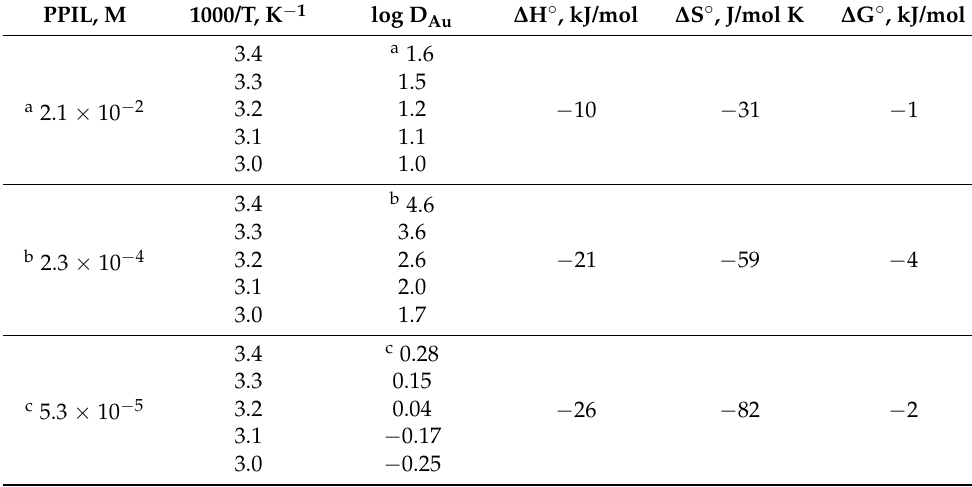
Table 2. Influence of the temperature on gold